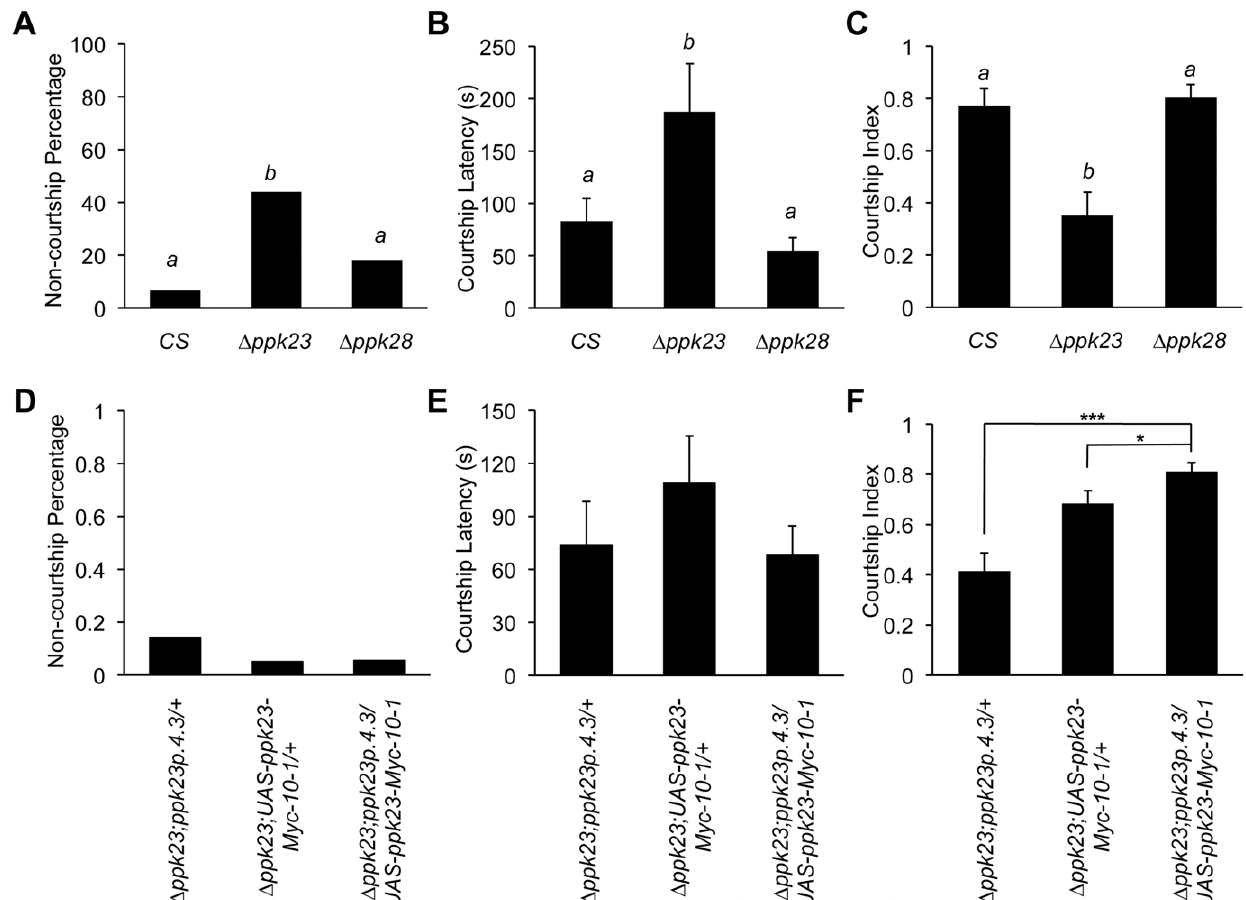
Figure 6. The ppk23 effect on courtship is not a general property of gustatory DEG/ENaC subunits. (A) Significantly higher proportion of D ppk23 males did not show any courtship behavior in a 10-min observation time under dark (‘‘red light’’) conditions towards females ( Chi-square test; p , 0.05 ). (B) D ppk23 males that did court showed increased courtship latency towards females relatve to CS controls or D ppk28 flies ( Kruskal-Wallis rank sum test, p , 0.05 ) and (C) reduced courtship index ( Kruskal-Wallis rank sum test , p , 0.001). n=24–27 flies per genotype. Error bars denote the standard error of the mean. Same letters above bars represent groups that were not statistically different in the post hoc test. All strains tested were in a common CS genetic background. (D–F) The effect of the D ppk23 allele on courtship index is rescued by overexpression of ppk23 cDNA (F, ANOVA, p , 0001, ***; pairwise comparisons using t -tests with non-pooled SD, n=25–30 for each genotype). The effects of the D ppk23 mutations on percent courtship and courtship latency were significantly reduced or absent in the genetic backgrounds of the rescue parental lines relative to flies that carrying D ppk23 alone, which precluded us from observing a significant rescue of these aspects of the ppk23 -induced courtship phenotype (D and E).